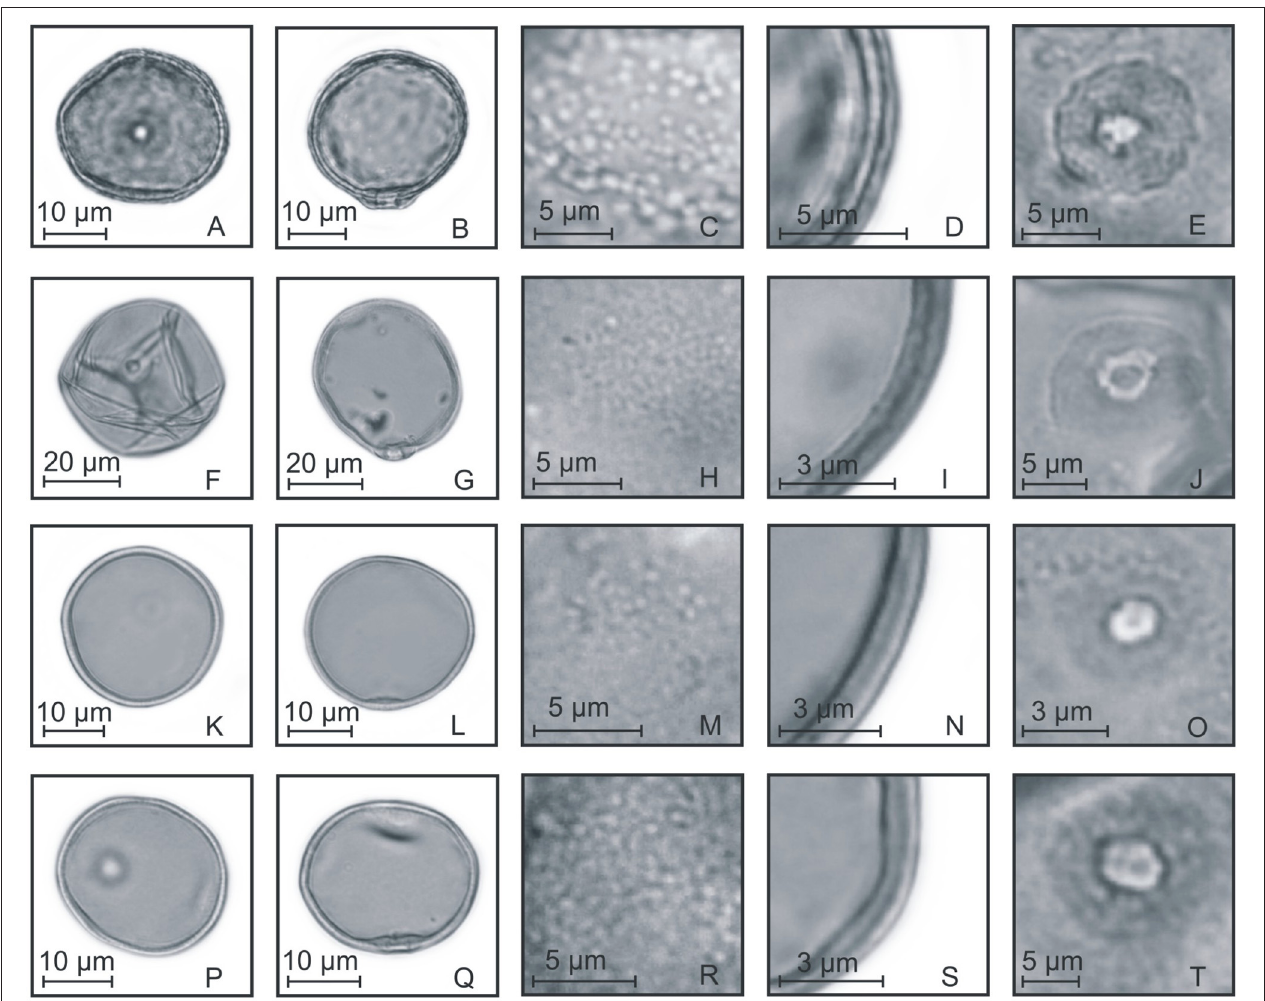
FIGURE 4 | Pollen grains of the subfamilies Anomochlooideae, Bambusoideae, and Pharoideae. (A–E) Streptochaeta spicata : PV (A) , EV (B) , detail of ornamentation (C) , detail of the thickness of the exine (D) , and detail of the aperture (E) ; (F–J) Chusquea juergensii : PV (F) , EV (G) , detail of ornamentation (H) , detail of the thickness of the exine (I) , and detail of the aperture (J) ; (K–O) Olyra latifolia : PV (K) , EV (L) , detail of ornamentation (M) , detail of the thickness of the exine (N) , and detail of the aperture (O) ; (P–T) Pharus lappulaceus : PV (P) , EV (Q) , detail of ornamentation (R) , detail of the thickness of the exine (S) , and detail of the aperture (T)